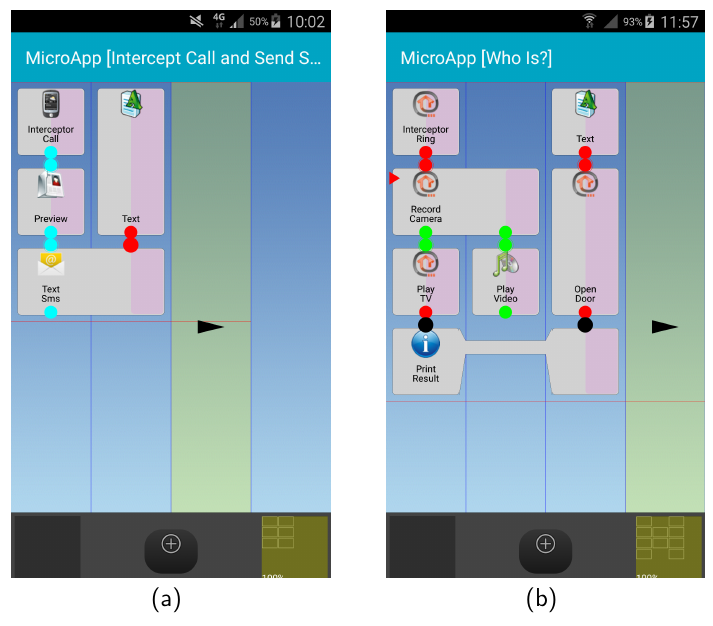
Figure 2. Two MicroApp design examples: Intercept Call and Send SMS ( a ); Who Is? ( b